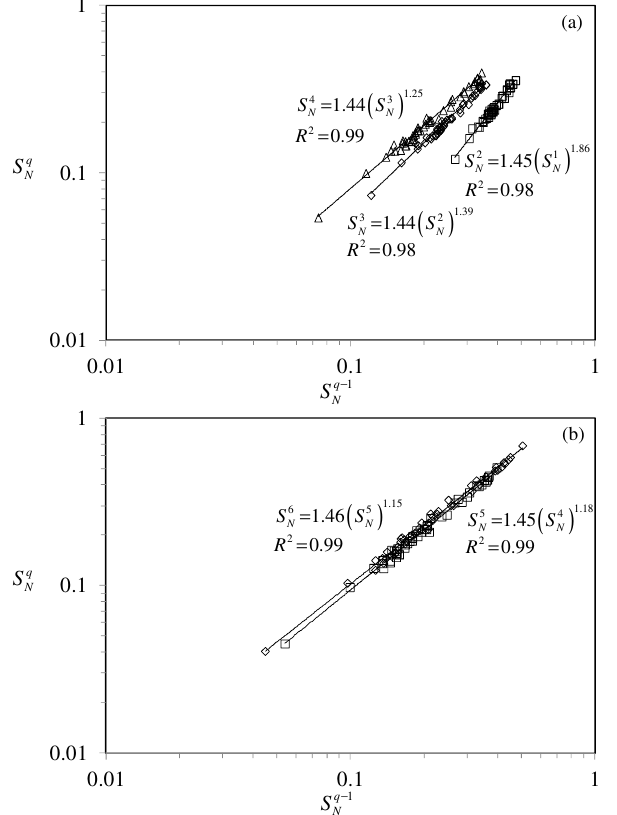
Fig. 14. Log-log variations of S q of Utah data from transects D N − 1 and H (bioturbated sandstone) with S q for 2 ≤ q ≤ 6. Solid lines N represent indicated regression fits. Linear regression equations and related regression coefficients ( R 2 ) are also reported. Fig. 16. ξ ( q) as a function of q (symbols) obtained via ESS based on ξ ( 1 ) = 0 . 26 computed for Utah data from transects D, H, and X (bioturbated sandstone and cross-bedded sandstone) by method of moments. Solid line has slope ξ ( 1 ) = 0 . 26 and broken line has slope H